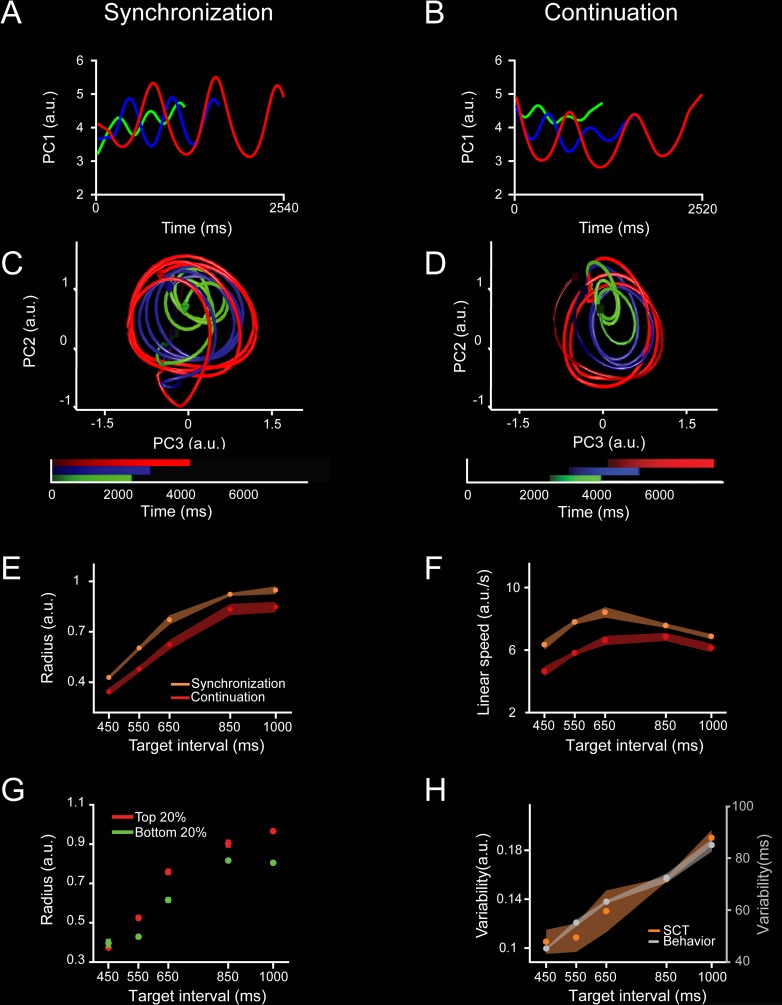
Neural population trajectories during SCT and their oscillatory dynamic properties.A, C. Projection of the neural activity in the MPC (1,477 neurons) during the SC of the SCT onto the first (A) or second and third PCs (C). The first three PCs explained the 10.7%, 3.8%, and 2.3% of the total variance. Each point in the trajectory represents the neural network state at a particular moment. The trajectory completes an oscillatory cycle on every produced interval during the synchronization and continuation phases of the SCT. Target interval in milliseconds is color coded (450, green; 650, blue; 1,000, red). Color progression within each target interval corresponds to the elapsed time. A cube indicates the beginning of each trajectory, while an octahedron indicates the end. B, D. Projection of the neural activity during CC of the SCT onto the first (B) or the second and third (D) PC. Color code is the same as (A). E. Monotonic increase of the radii in the oscillatory neural trajectories during SC (orange, mean ± SD, slope = 0.0009, constant = 0.0679, R2 = 0.9, p = 0.01) and CC (red, mean ± SD, slope = 0.0009, constant = −0.0296, R2 = 0.9, p < 0.01) as a function of target interval. F. Linear speed of neural trajectories during SC (orange, mean ± SD, slope = 0.0001, constant = 7.322, R2 = 0.0007, p = 0.896) and CC (red, mean ± SD, slope = 0.002, constant = 4.049, R2 = 0.354, p = 0.002) as a function of target interval (ANOVA main effect interval, F(4, 39) = 92.15, p < 0.0001; main effect condition, F(1,39) = 381.46, p < 0.0001; interval × condition interaction, F(4, 39) = 15.15, p < 0.0001). The linear speed was similar (SC) or showed a slight increase (CC) with the target interval. G. Neural trajectory radii for the top 20% (red, slope = 0.0011, constant = −0.035, R2 = 0.7, p < 0.0001) and bottom 20% (green, slope = 0.00088, constant = −0.009, R2 = 0.75, p < 0.0001) inter-tap intervals across target intervals. Note that on those intervals in which the monkeys tended to produce shorter inter-tap durations, the state trajectory radius was smaller, and vice versa (ANOVA main effect interval, F(4, 40) = 155.7, p < 0.0001; main effect population, F(1, 40) = 33.3, p < 0.0001; interval × population interaction, F(4, 40) = 3.98, p = 0.008). H. Variability (SD) of SCT rotational neural trajectories (orange, mean ± SD, normalized data slope = 0.0019, constant = −1.02, R2 = 0.94, p = 0.005) and the monkeys’ produced intervals (gray, mean ± SD, normalized data slope = 0.005, constant = −0.721, R2 = 0.98, p = 0.0008) as a function of target interval. The Weber increase in tapping variability was not statistically different from the increase in the variability of neural trajectories across target intervals (normalized data, slope t test = 0.86, p = 0.42; constant t test = 1.36, p = 0.22). Underlying data are available in https://doid.gin.g-node.org/d315b3db0cee15869b3d9ed164f88cfa/. a.u., arbitrary unit; CC, continuation condition; MPC, medial premotor cortex; PC, principal component; SC, synchronization condition; SCT, synchronization-continuation task.